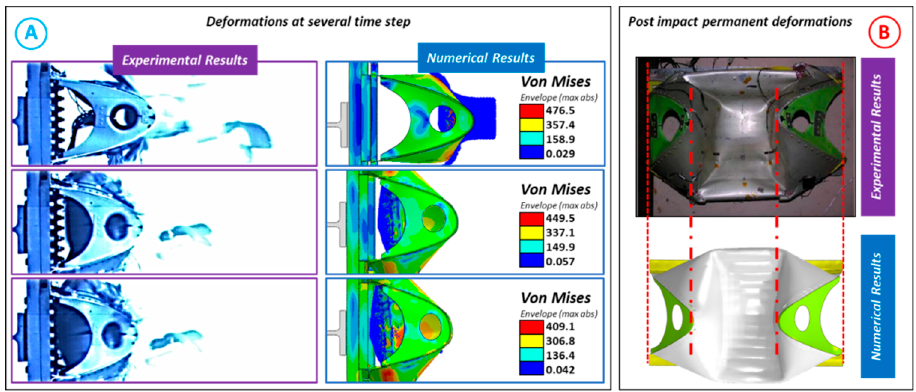
Figure 4. Experimental–numerical comparison. ( A ) Deformed shape during the test; ( B ) permanent deformation after the impact.